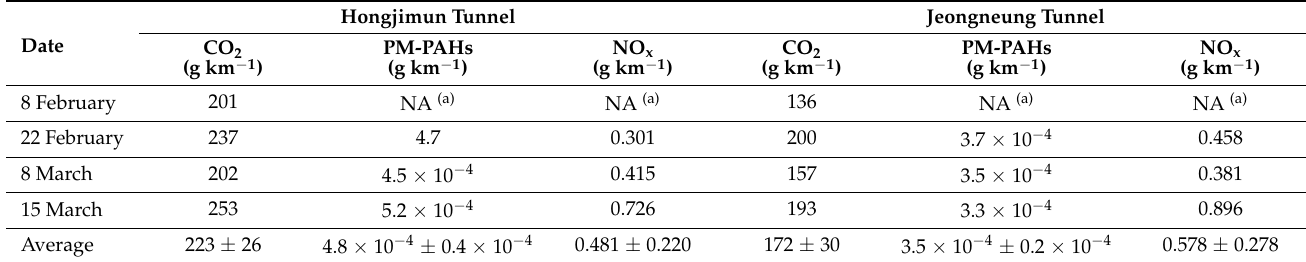
Table 2. Summary of the estimated CO 2 , PM-PAH, and NO x emission